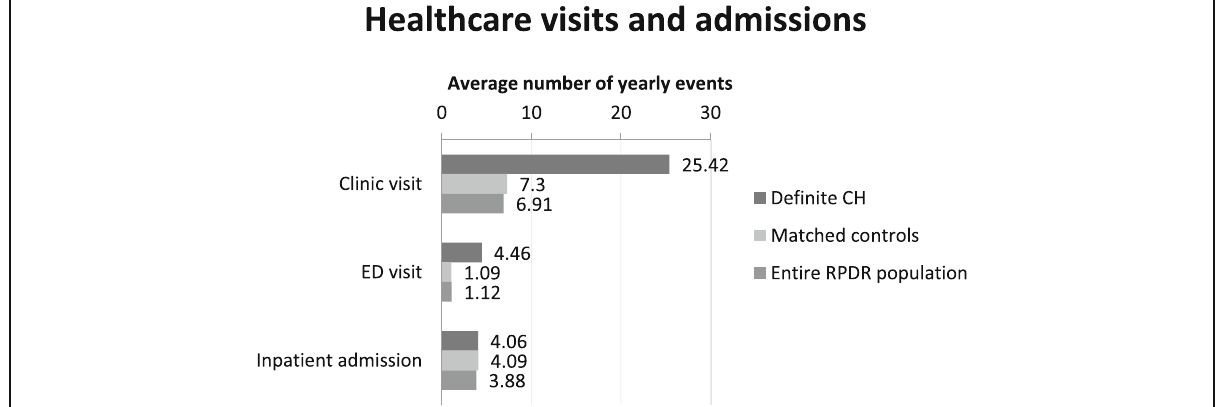
Fig. 3 The average number of yearly emergency department (ED) and clinic visits was higher for CH patients compared with the entire RPDR population or